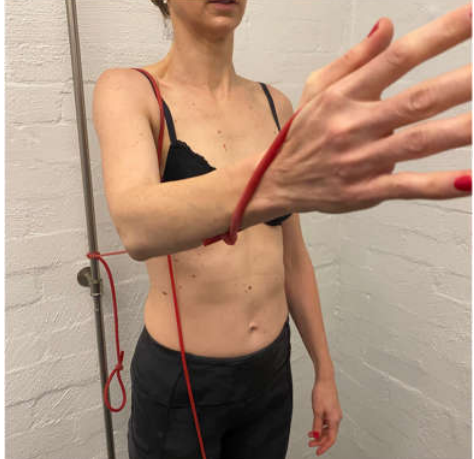
Figure 9. Theraband TM flexion drill.